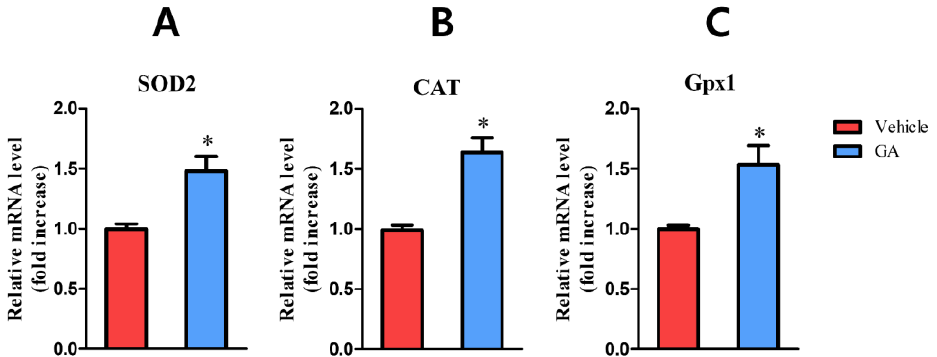
Figure 5. Gallic acid regulates the expression of anti-oxidant genes. ( A ): SOD2, ( B ): CAT, ( C ): Gpx1. Asterisk (*) indicates p - value < 0.05. Reproduced with permission from Yang et al., “Gallic Acid Promotes Wound Healing in Normal and Hyperglucidic Conditions”, published by MDPI, 2016 [61].